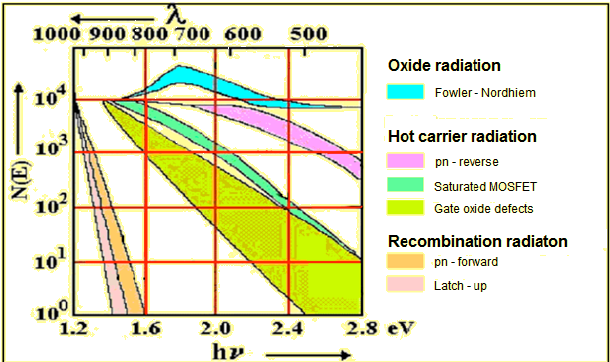
Fig. 4. Typical emission spectrum of most defects